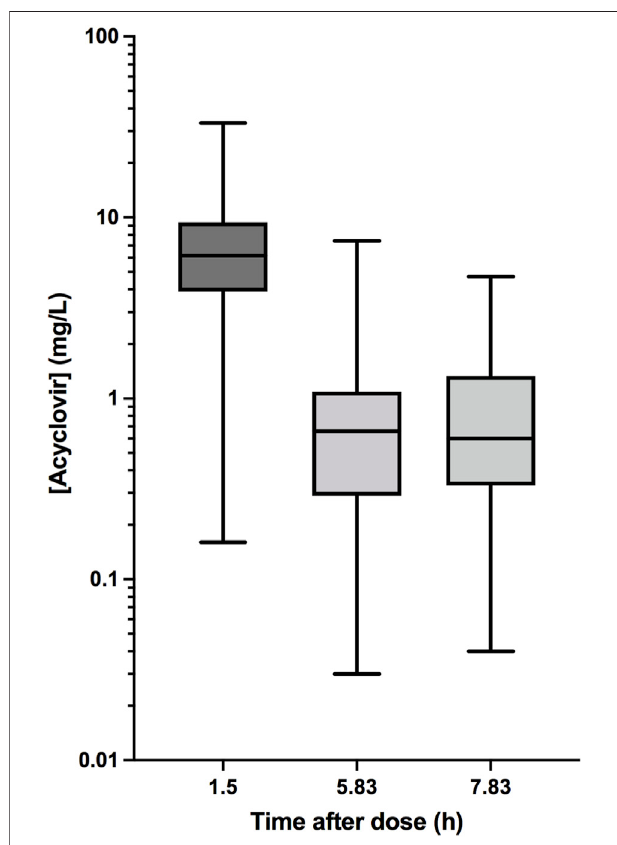
FIGURE 2 | Box-and-whiskers plot of single measured plasma concentrations of acyclovir 30 min after the end of the infusion (1.5 h) and 10 min before the next dose in 6-h (5.83 h) and 8-h (7.83 h) regimens.